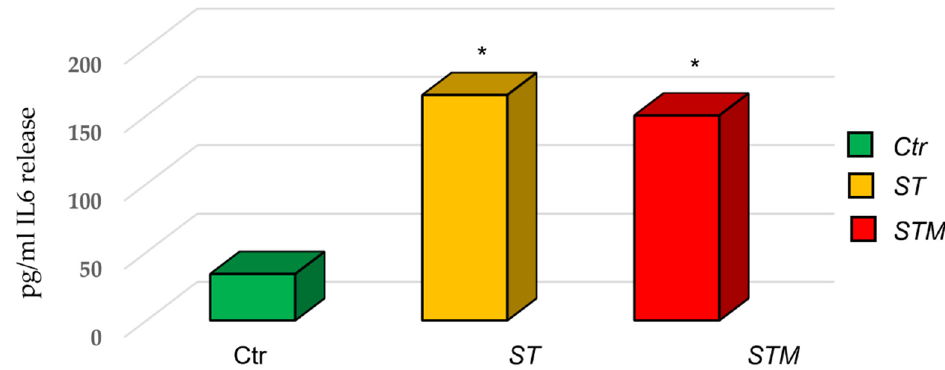
Figure 4. ST and STM’s effect on IL6 release by CF33 cells. Significance of data was calculated by t -test. * p < 0.05.